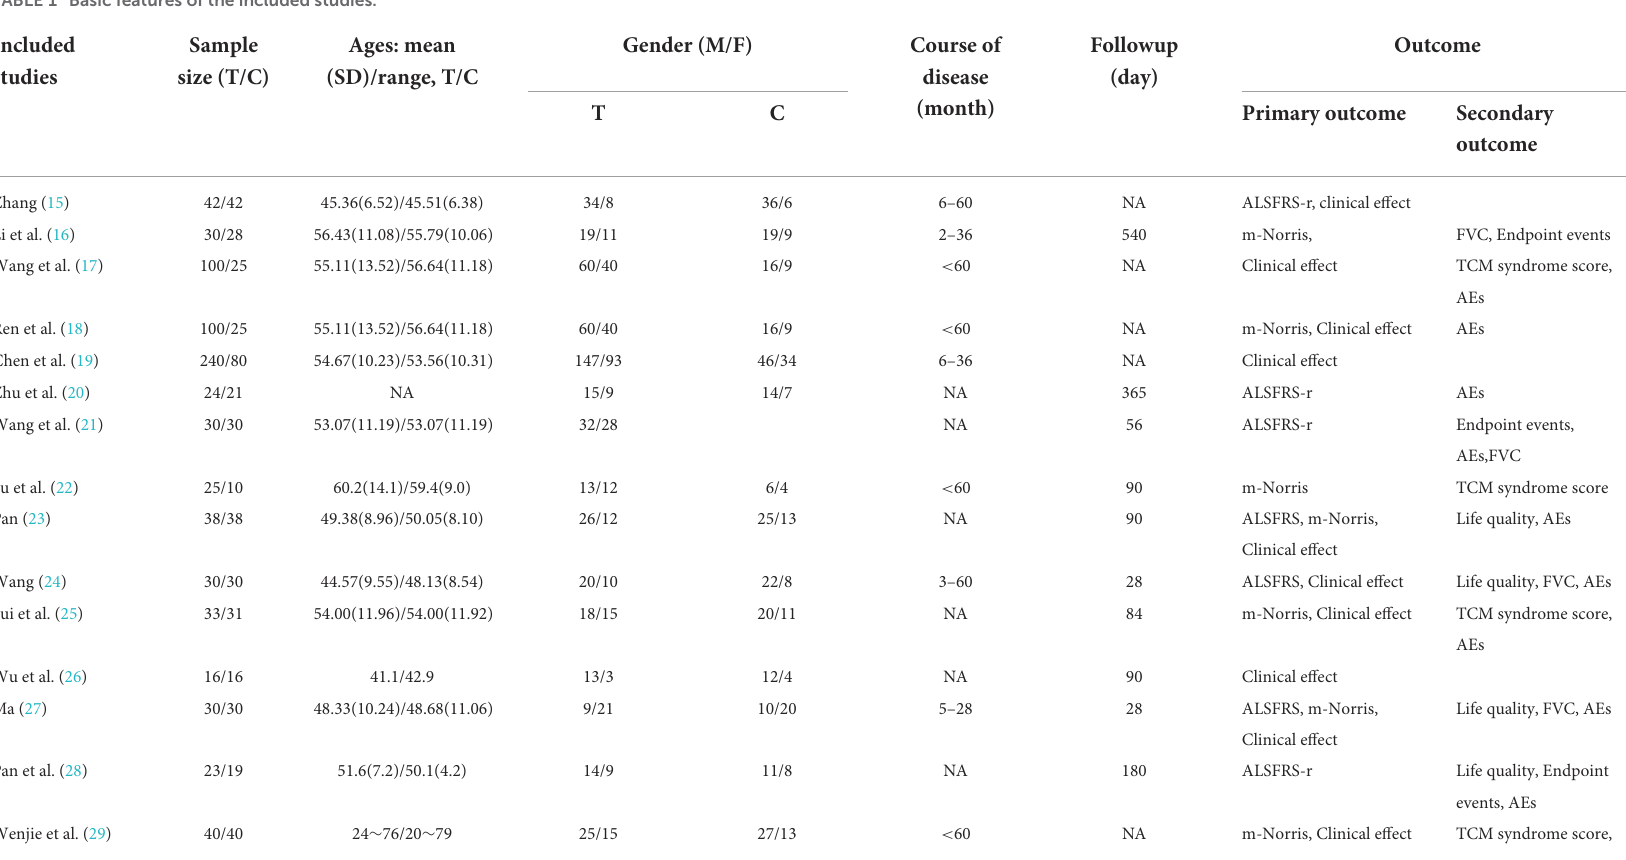
TABLE 1 Basic features of the included